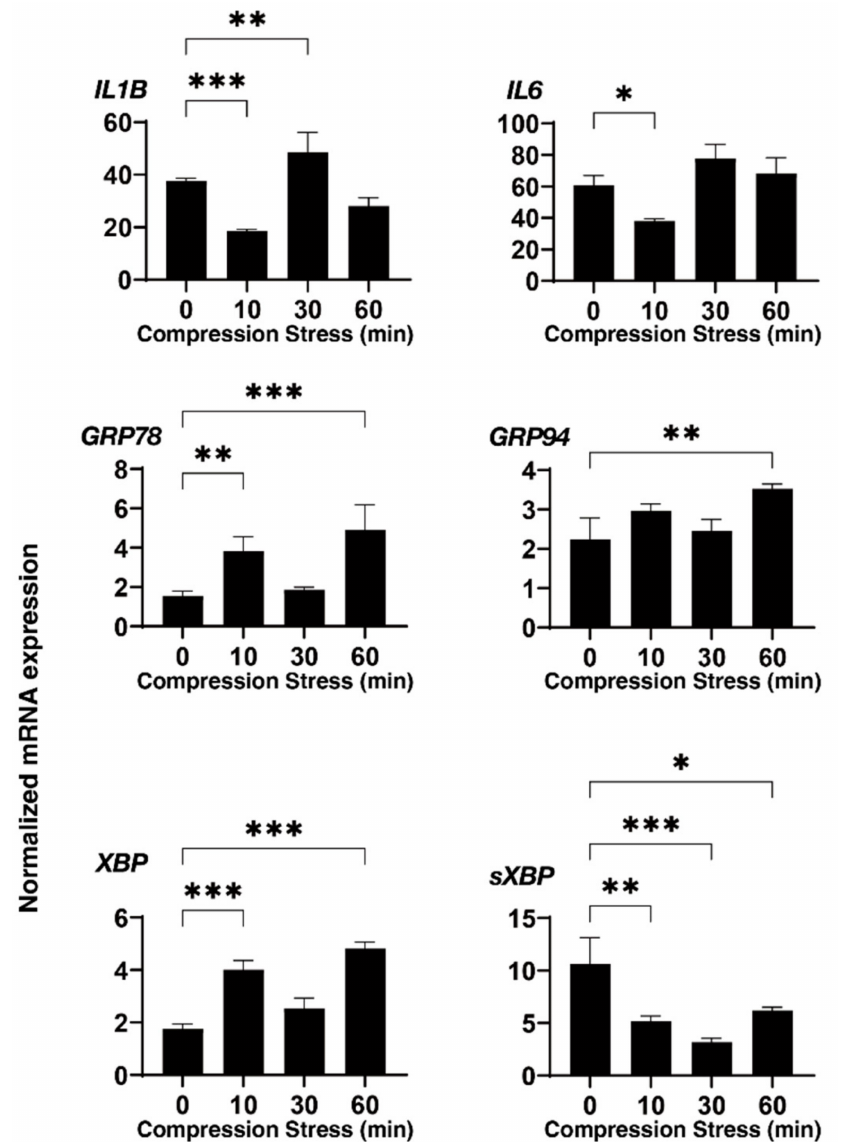
Figure 4. mRNA expression of the inflammatory cytokines and ER stress-related factors of the 3D HTM spheroids after a mechanical compression stress for different time durations. Untreated 3D HTM spheroids were mechanically compressed on day 6 for 10, 30, or 60 min and subjected to a qPCR analysis to estimate the expression of mRNA of the inflammatory cytokines (IL1 and IL6) and ER stress-related factors (glucose regulator protein (GRP) 78, GRP94, X-box binding protein 1 (XBP1), and spliced XBP1 (sXBP1)). All the experiments were performed in duplicate using fresh preparations ( n = 4). The data are presented as the arithmetic means ± standard error of the mean (SEM). Note: * p < 0.05, ** p < 0.01, *** p < 0.005 (ANOVA followed by Tukey’s multiple comparison